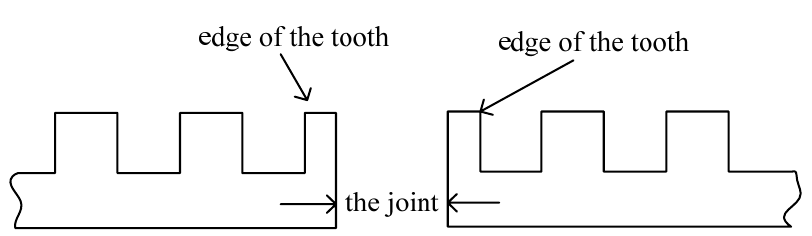
Figure 7. The joint of long stators.